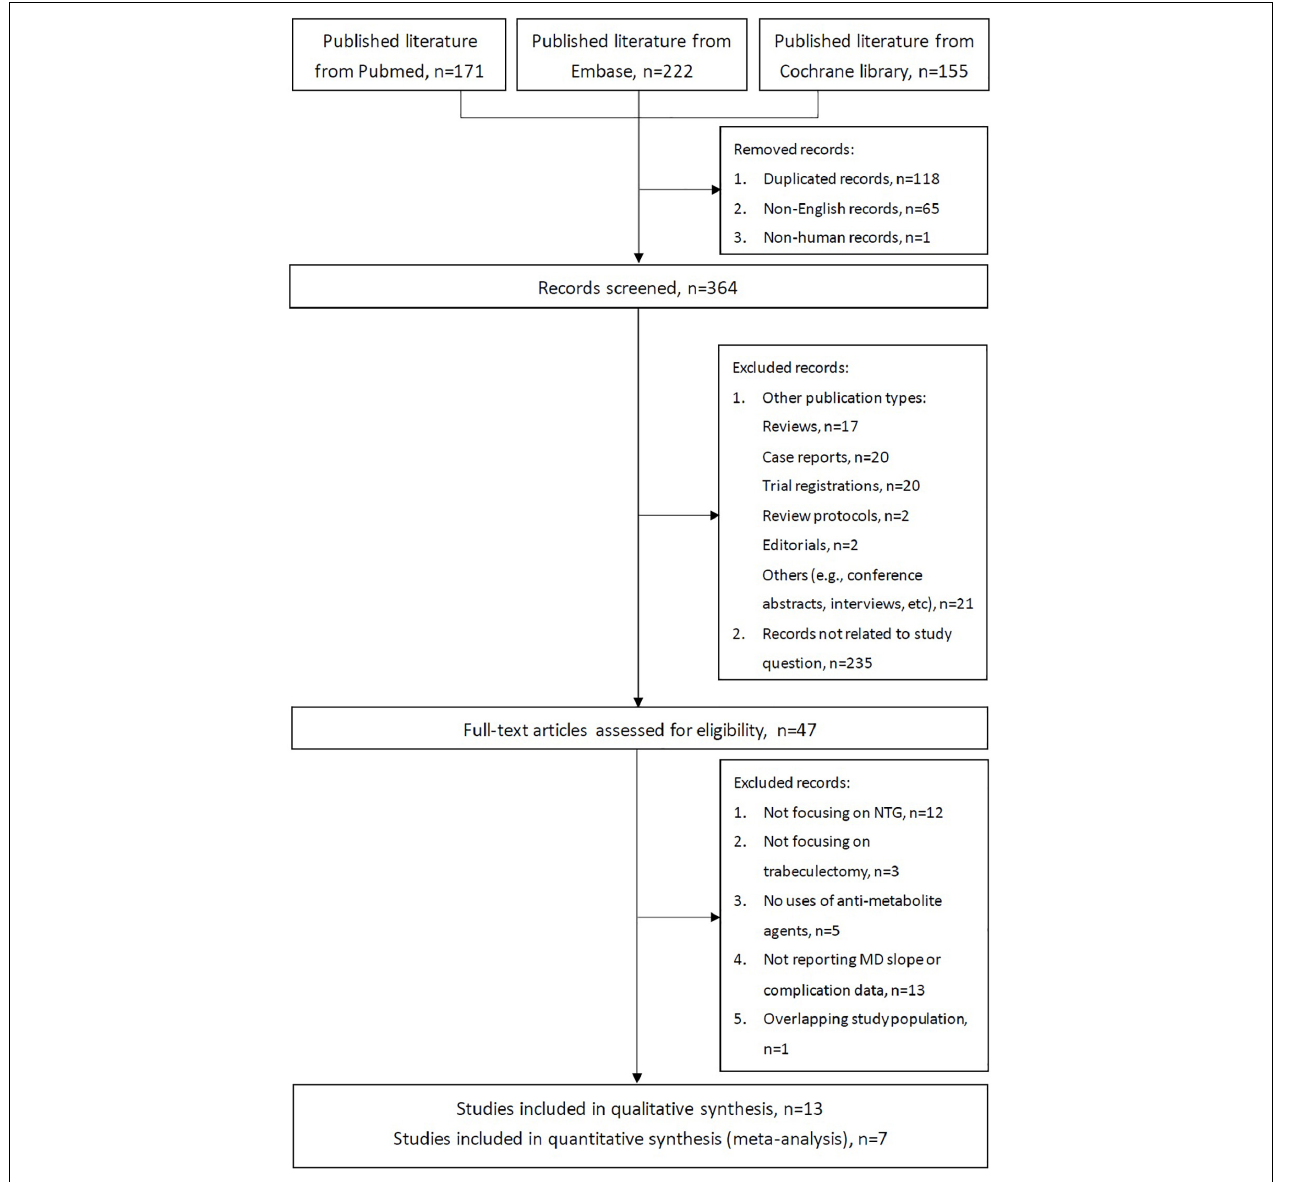
FIGURE 1 | PRISMA